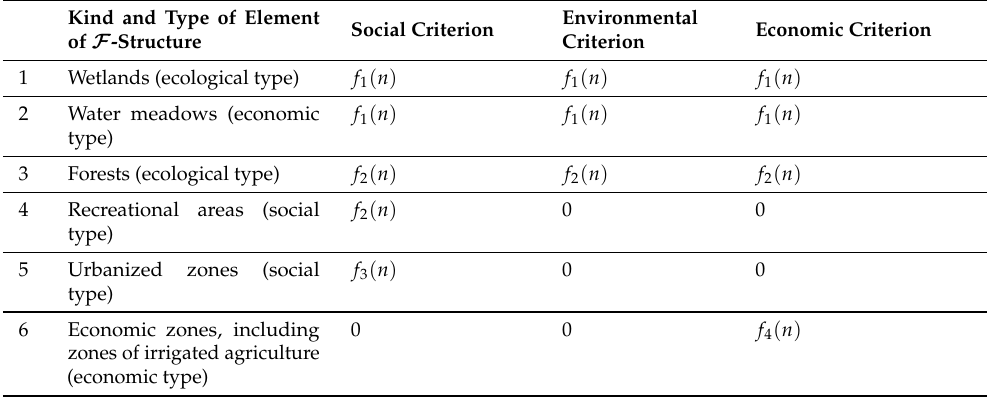
Table 1. Kinds and types of the main elements of the F -structure of the floodplain territory and characteristic functions of the criteria of